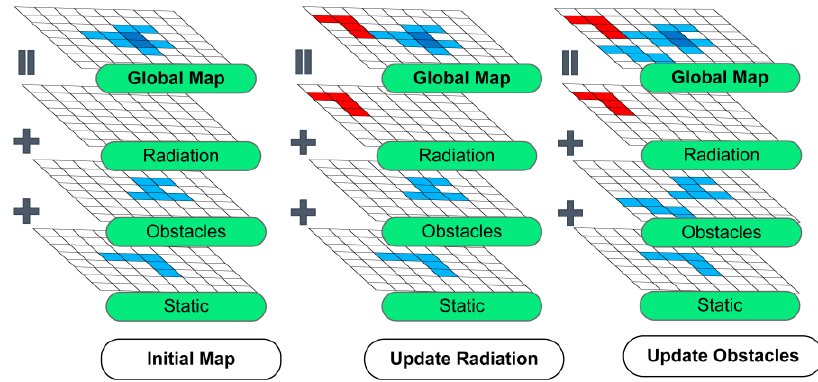
Figure 5. Radiation map’s update process